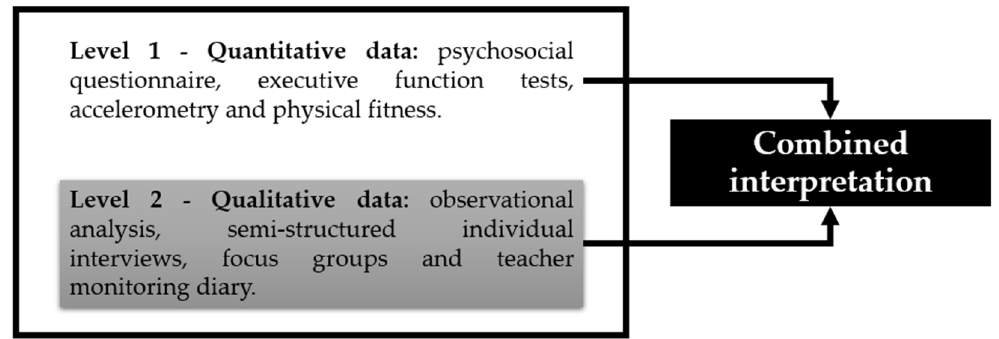
Figure 1. Multilevel triangulation mixed methods research design.